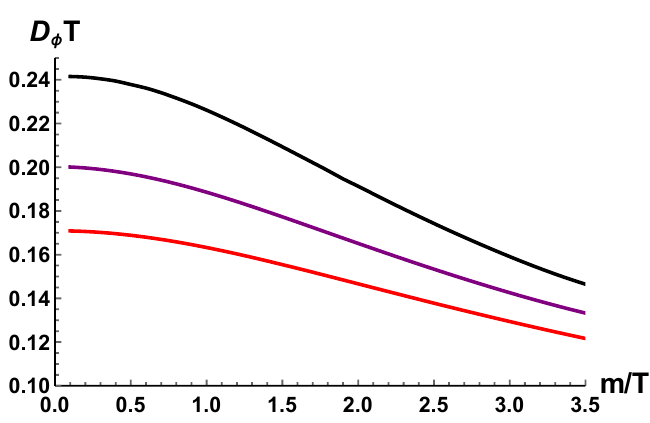
Figure 9 . The numerical values for the Goldstone di(cid:11)usion constant in function of m=T for the potentials N = 3 ; 4 ; 5 (from black, top; to red,